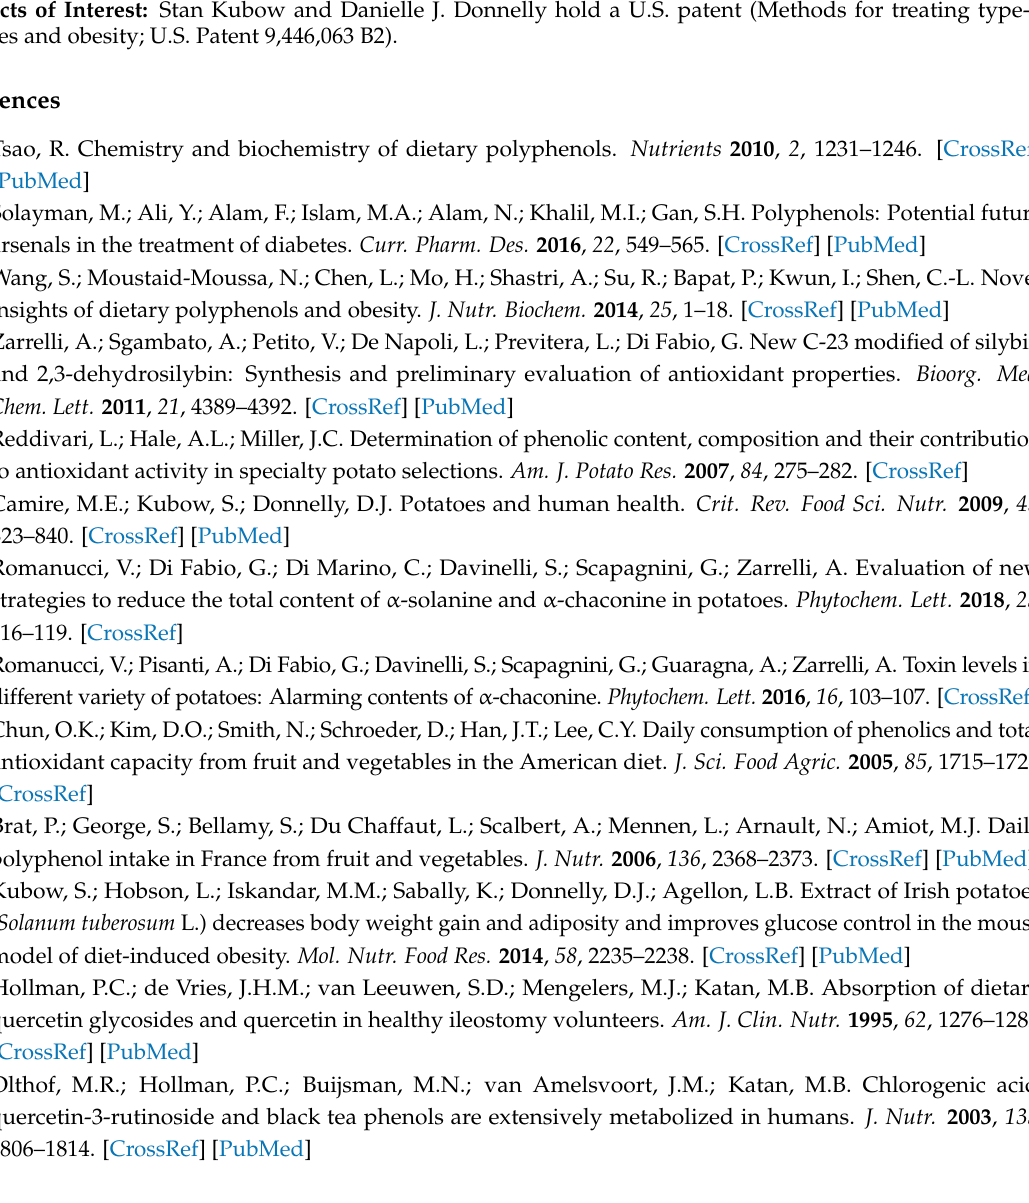
Figure S1: HPLC Chromatograms of (poly)phenolics in colonic vessels at baseline and after 24 h of fermentation. Figure S2: HPLC Chromatograms of polyphenols in (A) digested potato extract, (B) stomach vessel (V1), and (C) small intestine vessel (V2) after 24 h of